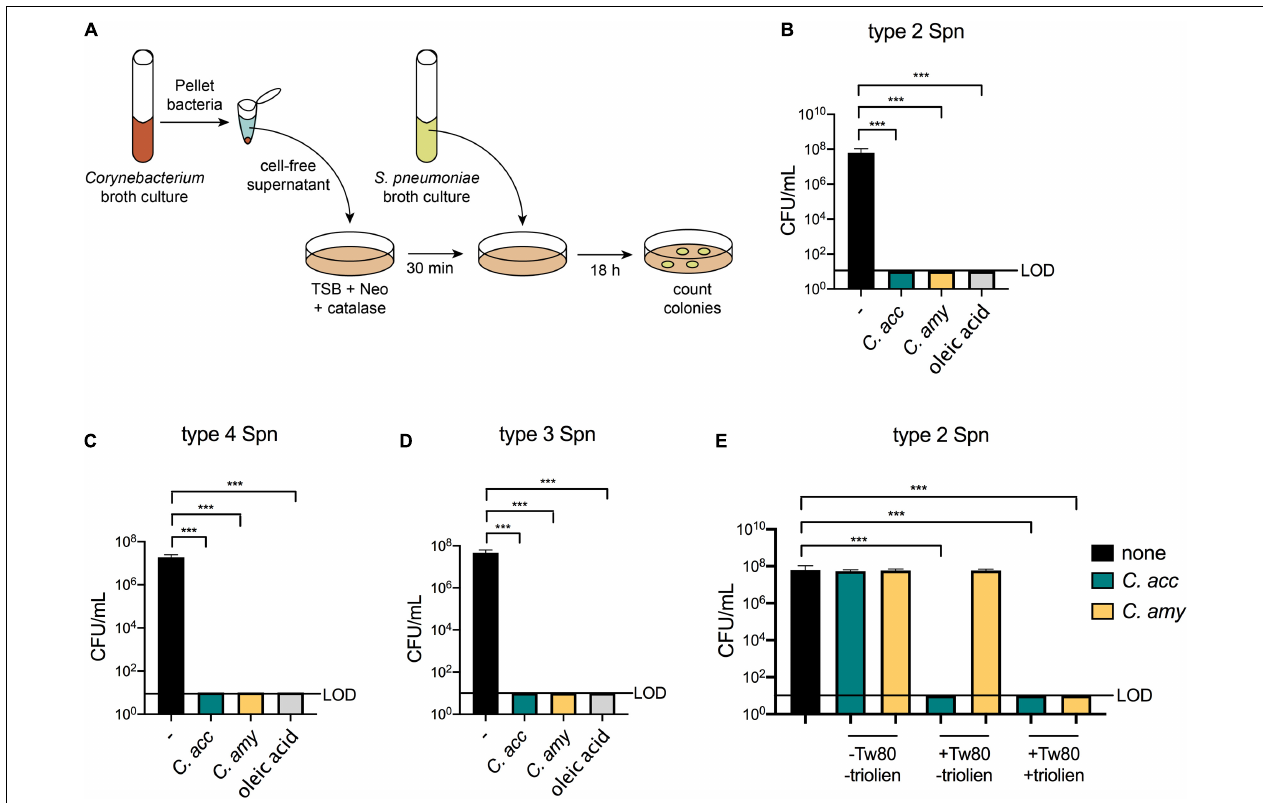
FIGURE 1 | Inhibition of S. pneumoniae growth in vitro by lipophilic and non-lipophilic Corynebacterium species. Supernatant inhibition assay schematic using tryptic soy broth (TSB), neomycin (Neo), and catalase plates (A) . Growth of type 2 S. pneumoniae (Spn), (B) , type 4 Spn (C) , and type 3 Spn (D) on untreated plates (–) or on plates pre-treated with supernatants from C. accolens ( C. acc ) or C. amycolatum ( C. amy ) or with 180 mg/mL oleic acid. Growth of type 2 Spn on untreated plates (–) or on plates pre-treated with supernatants from C. acc or C. amy grown in BHI with or without 1% Tween 80 and 180 mg/mL triolein (E) . Limit of detection (LOD) is indicated. Data are pooled from three independent experiments in duplicate. *** p < 0.001, ANOVA.